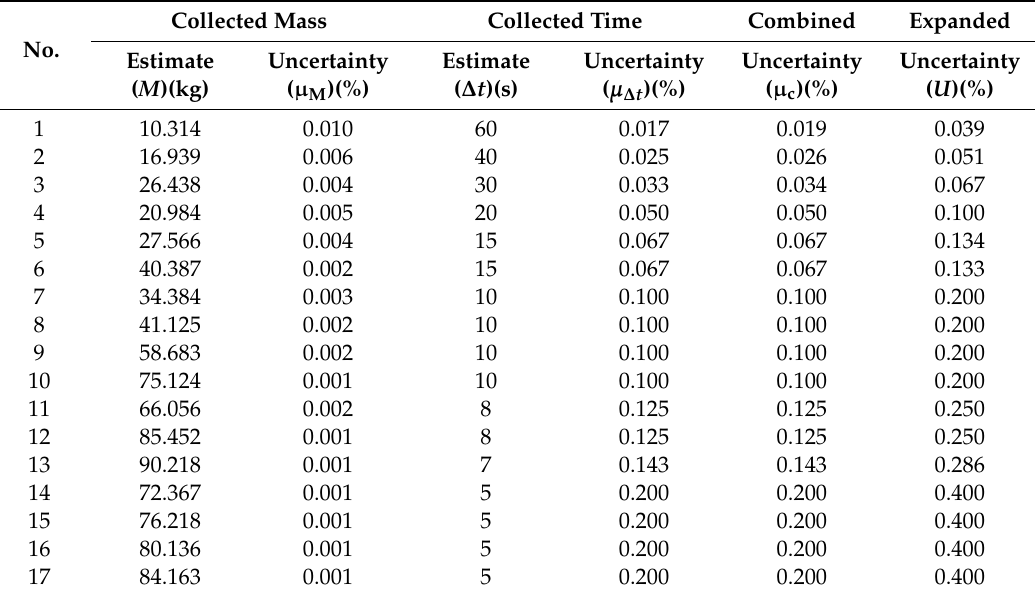
Table 5. Experiment uncertainty for turbulent